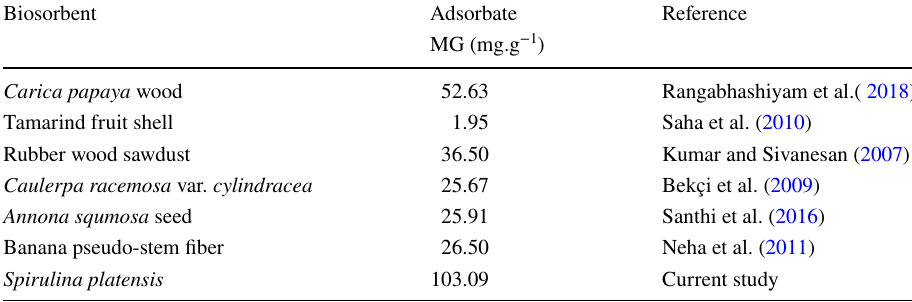
Table 7 Comparison of Langmuir biosorption capacities of MG with results from previous